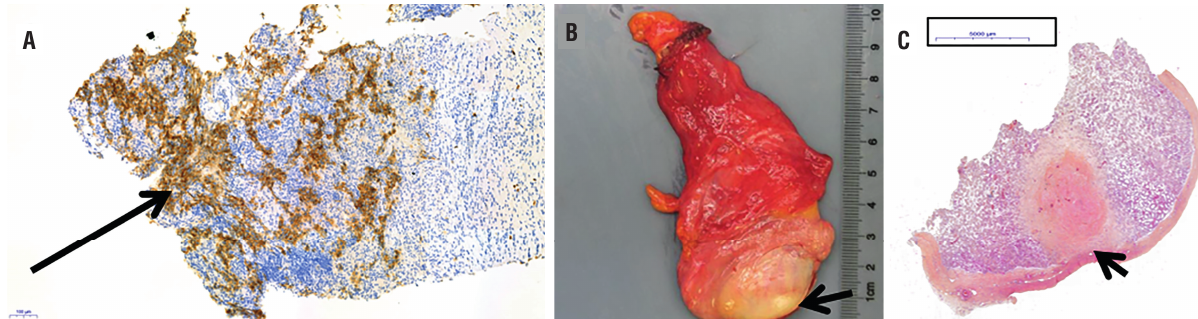
Figure 3 - Pathological examinations of the third 34 years old